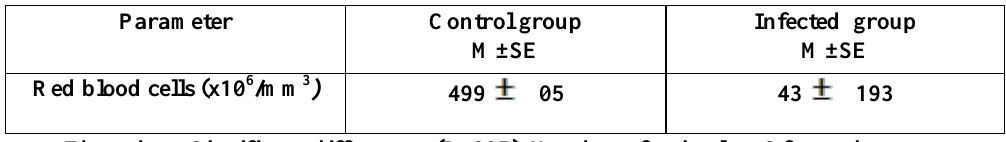
Table (3) Effect of E coli infection on mean of Red Blood Cells (RBCs) count.